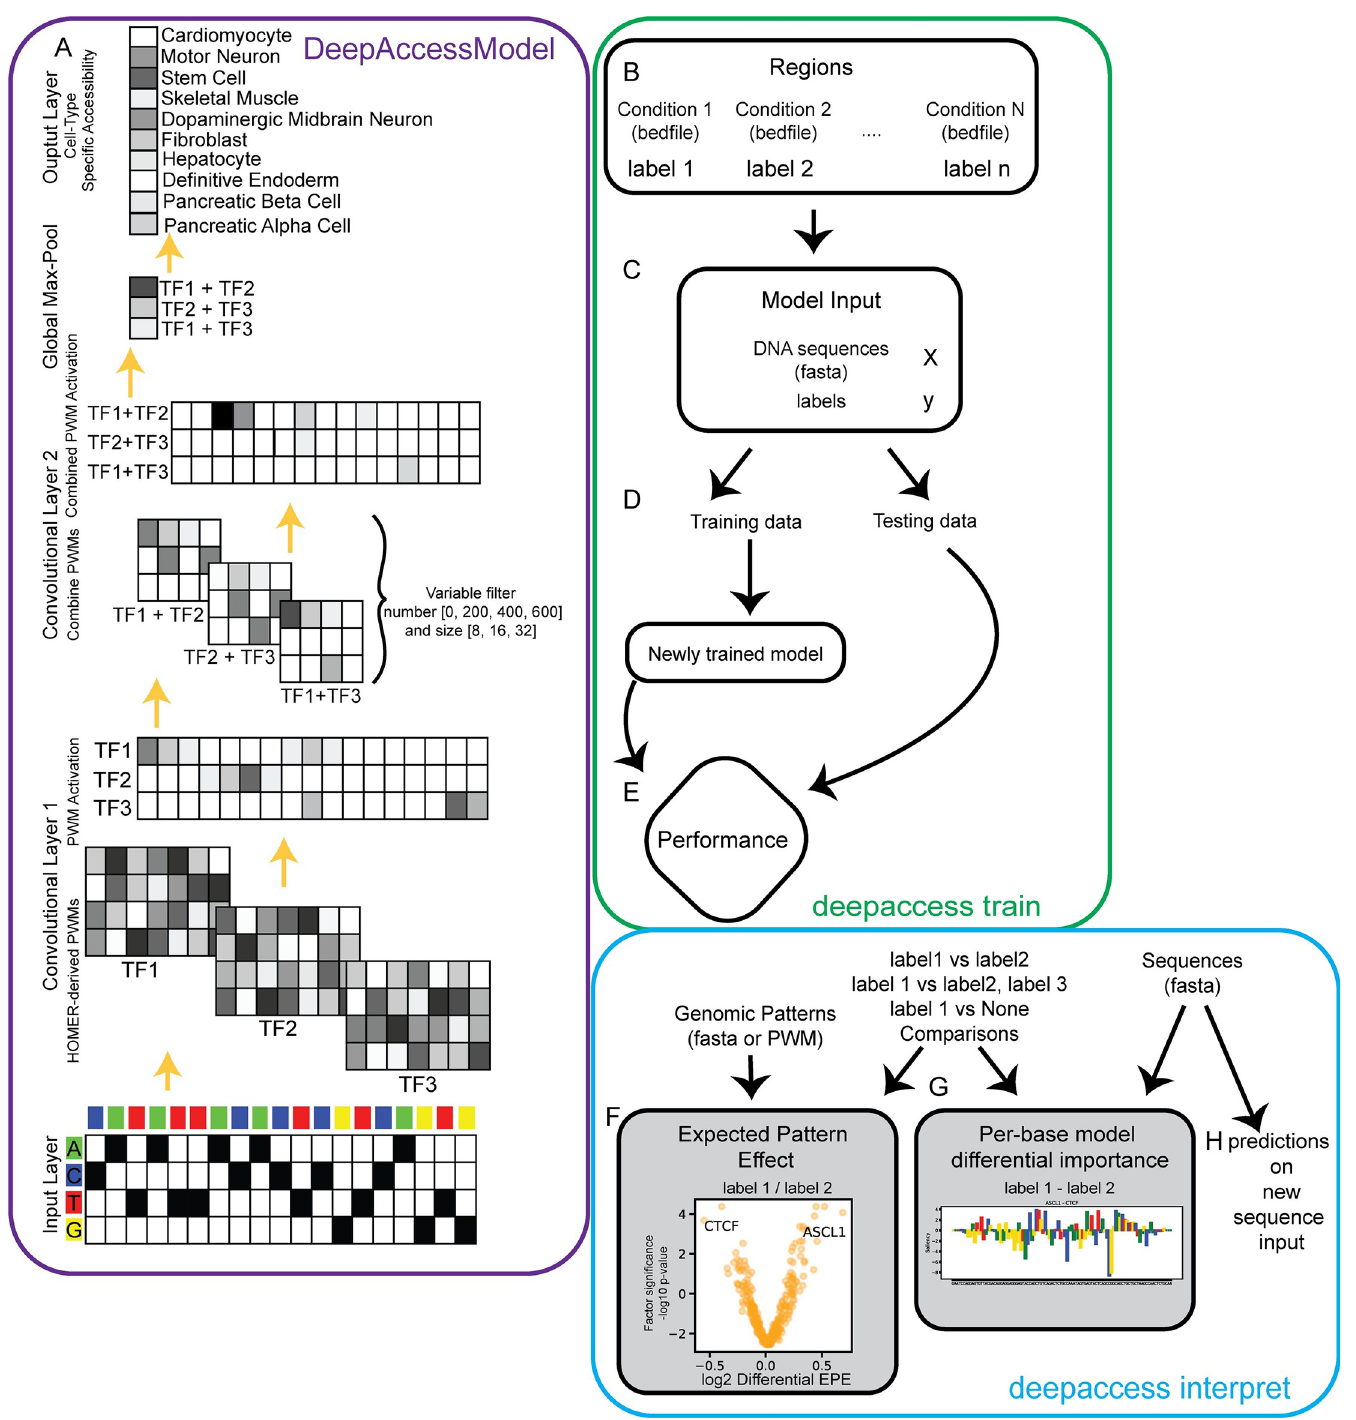
Fig 4. Accessible and interpretable deep learning with DeepAccess. (A) Core DeepAccess model example trained to predict accessibility from 100nt DNA sequence using ATAC-seq data from 10 mouse cell types. Input layer is one-hot encoding of DNA sequence. Convolutional layers scan for transcription factor motifs using position weight matrices derived from the HOMER database. Ensemble of models with variable filter number and size in the second convolutional layer combine transcription factor motifs. Global max pooling layer condenses results into maximally activating position for convolutional filter. Output is the multi-task accessibility which can be interpreted as the probability that an input DNA sequence will be accessible in each cell type, state, or condition. The DeepAccess system takes as input either (B) genomic regions from multiple conditions with labels, or (C) DNA sequences as fasta files and labels. (D) Data is split into training and testing, and model is trained with early stopping criteria based on a validation subset of ATAC-seq data. (E) Model performance is computed. Finally, results of newly trained model can be